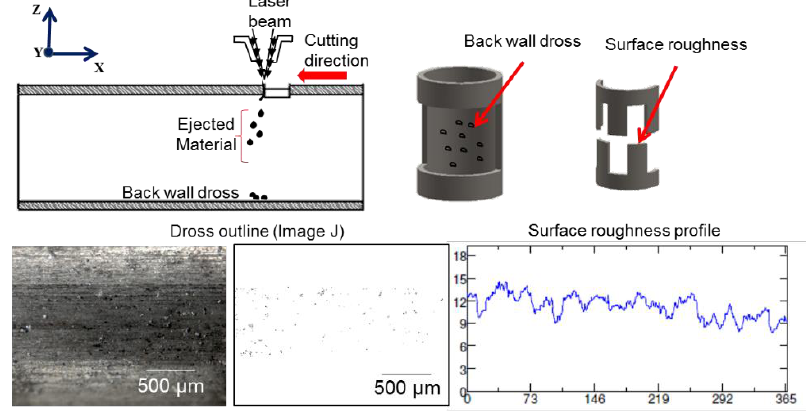
Figure 4. Quality-related response variables of interest.